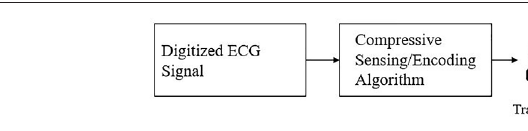
FIGURE 2 | Block diagram of Generic ECG Compressive Sensing